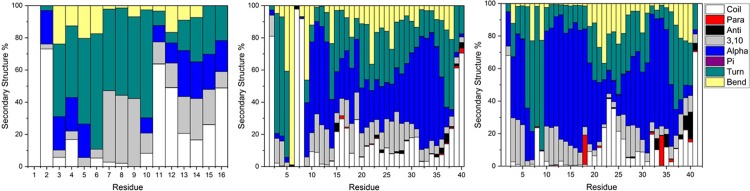
Peptide secondary structure percentage, by residue, for Al-Aβ16, Al-Aβ40 and Al-Aβ42.